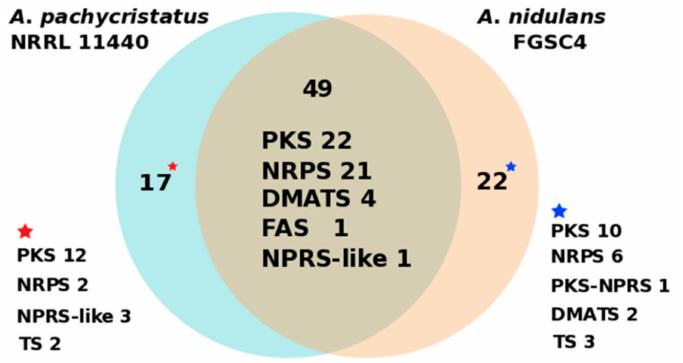
Figure 5. Numbers of distinct and shared secondary metabolite core catalytic genes between A . nidulans FGSC4 and A. pachycristatus NRRL 11440. PKS (polyketide synthase), NRPS (nonribosomal peptide synthetase), DMATS (dimethylallyltryptophan synthase), FAS (fatty acid synthase), and TS (terpene